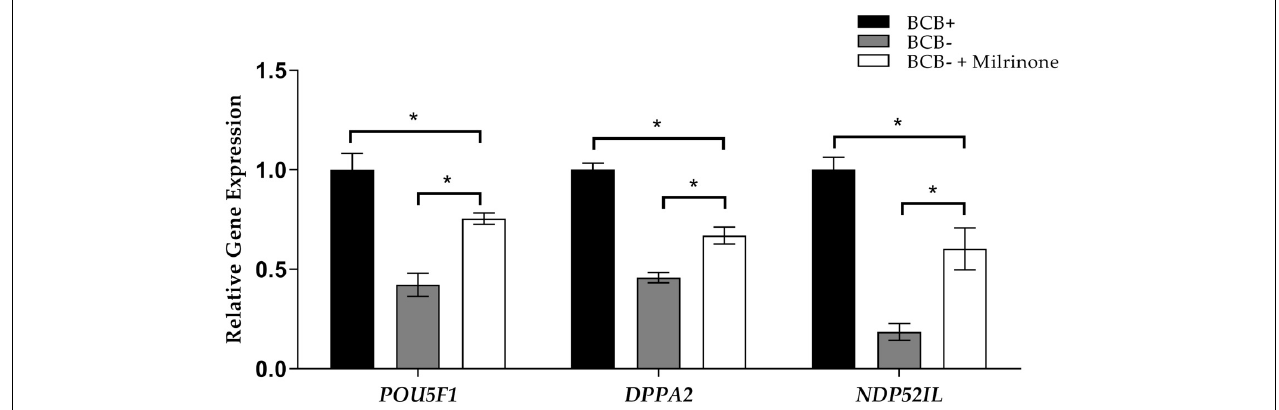
FIGURE 3 | Relative expression levels of the POU5F1 , DPPA2 , and NDP52IL genes in cloned blastocysts derived from brilliant cresyl blue non-stained (BCB − ) oocytes, BCB − oocytes supplemented with 75 µ M milrinone, and BCB − stained (BCB +) oocytes. Asterisks indicate P ≤ 0.05 when compared with each other.